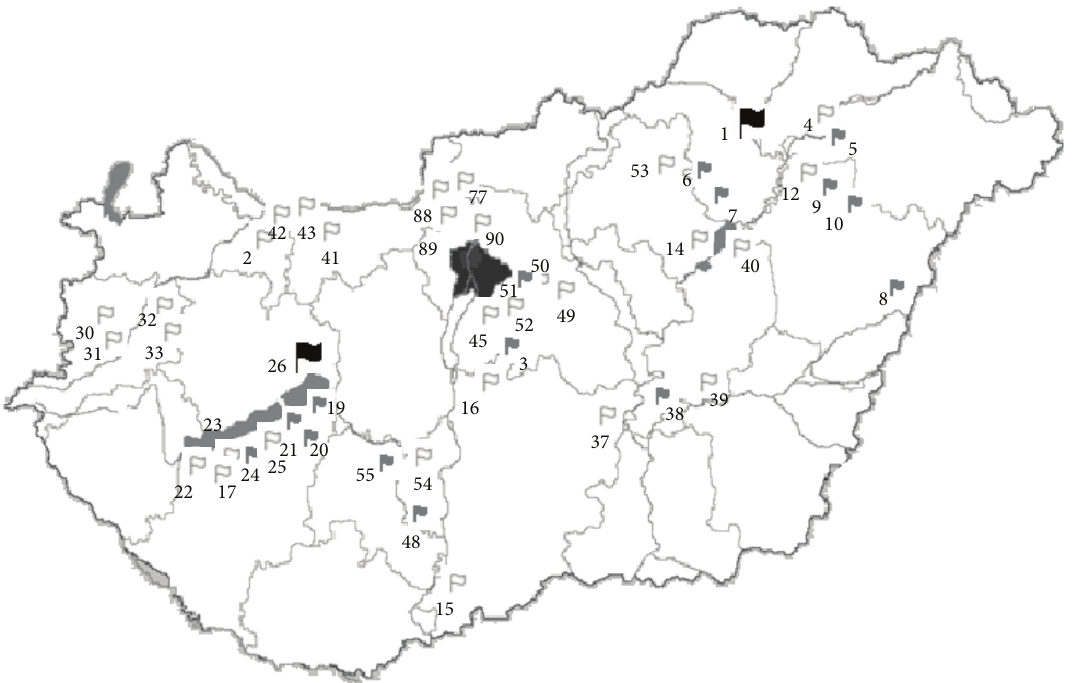
Figure 1: Sampling sites in the national survey between 1999 and